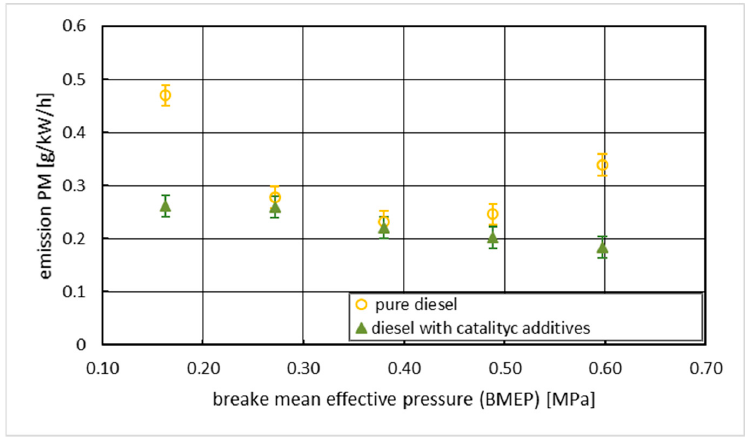
Figure 4. NOx emission vs. brake mean effective pressure at an engine speed of 2000 rpm.